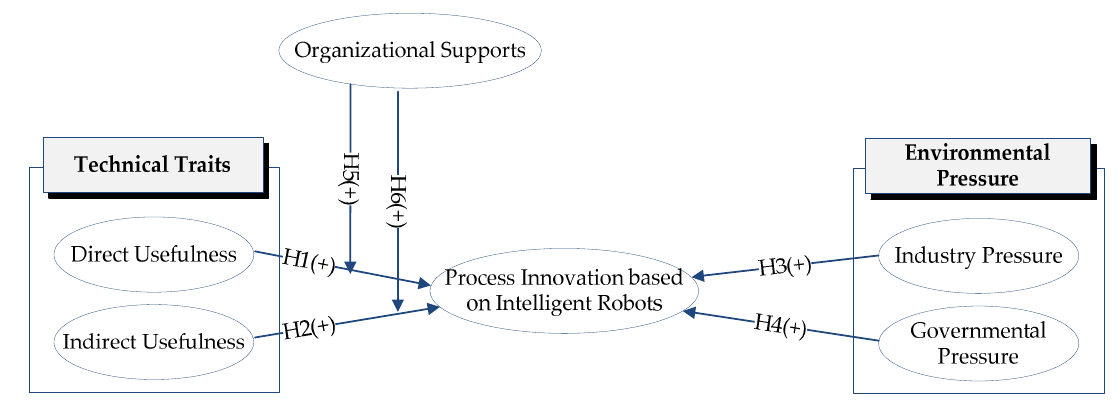
Figure 1. Research model and hypotheses.